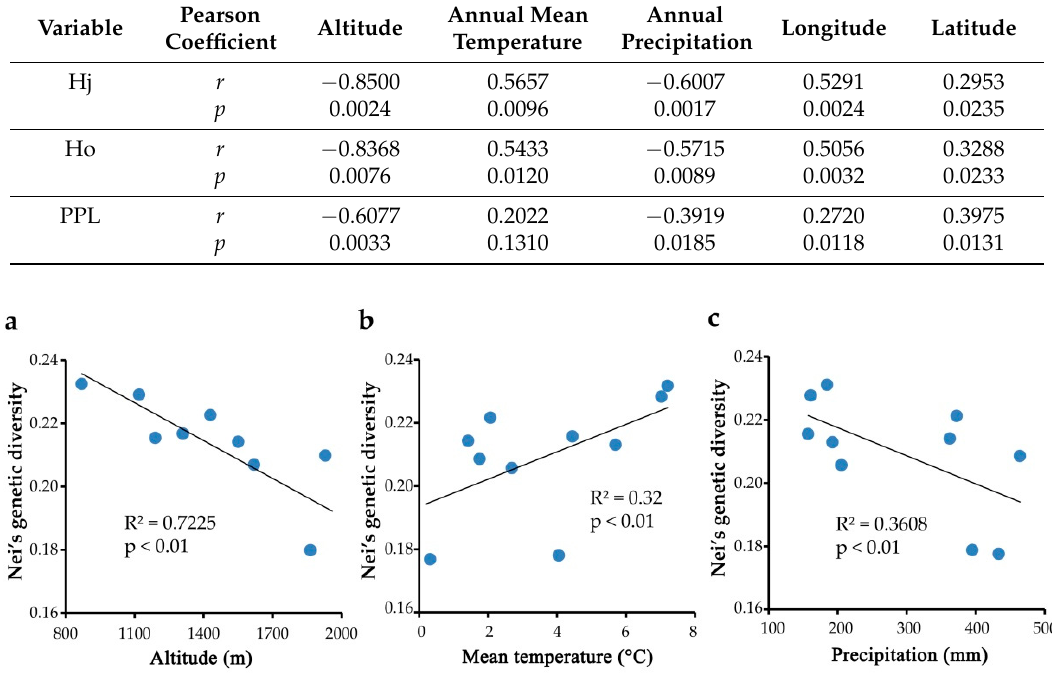
Table 5. Pearson correlation analysis ( r ) between genetic diversity and environmental factors.